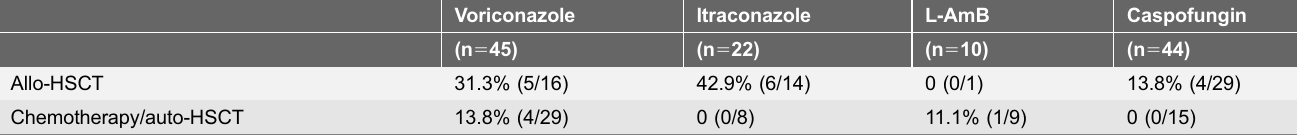
Table 3. Recurrence rates of different SAP agents in patients receiving allo-HSCT and